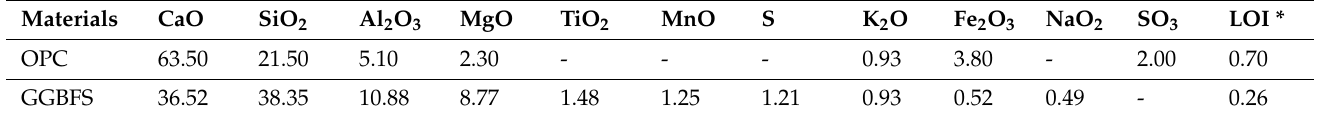
Table 1. Chemical compositions of OPC and GGBFS (wt.%).